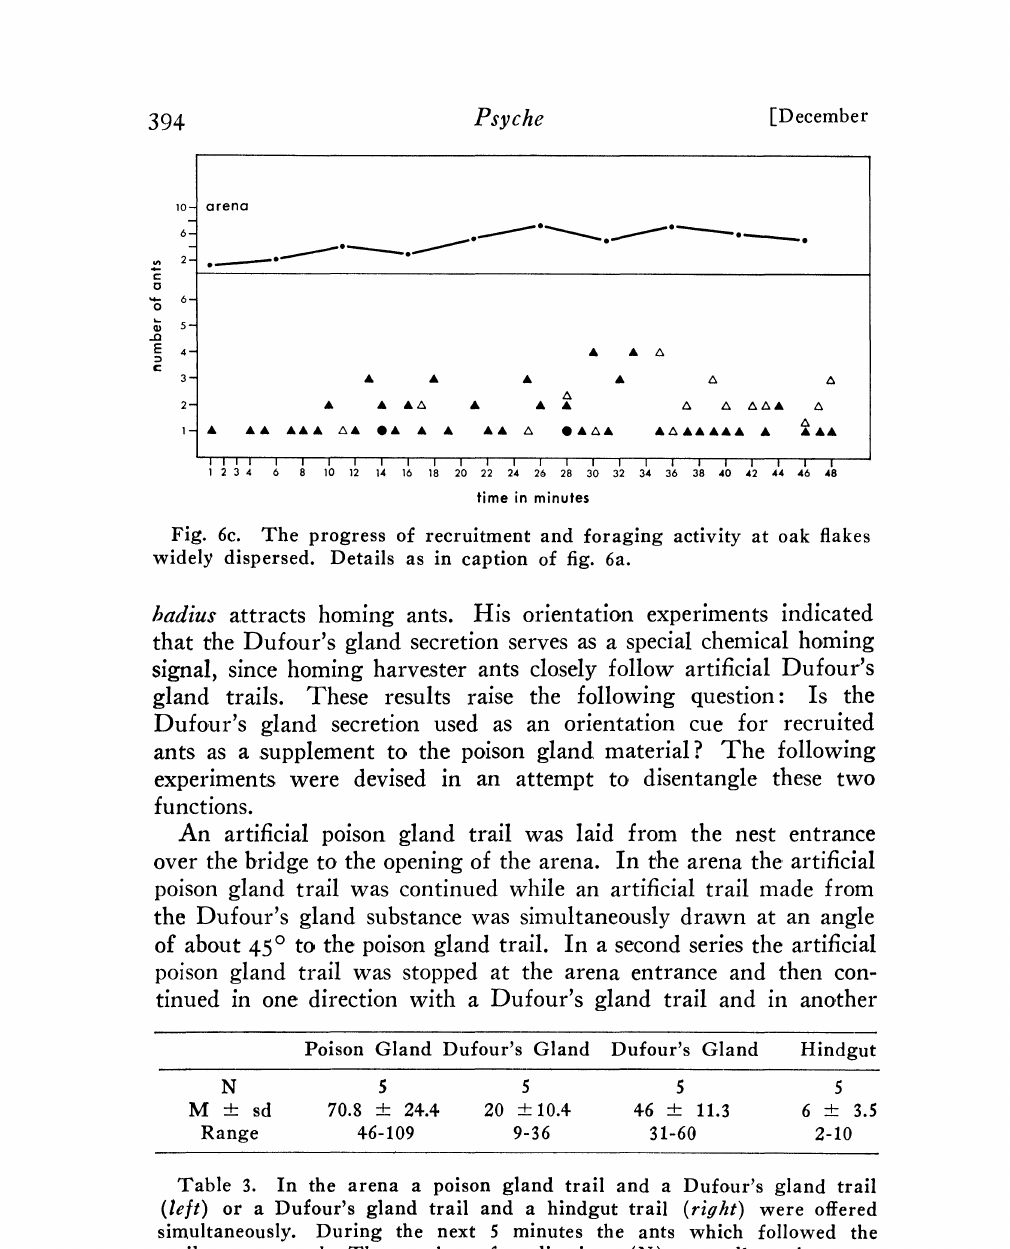
Table 3. In the arena a poison gland trail and a Dufour’s gland trail (left) or a Dufour’s gland trail and a hindgut trail (right) were offered simultaneously. During the